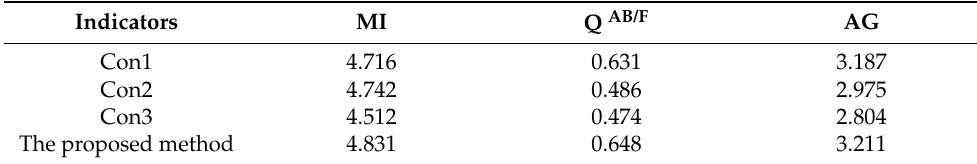
Table 4. The objective evaluation for self-comparison.